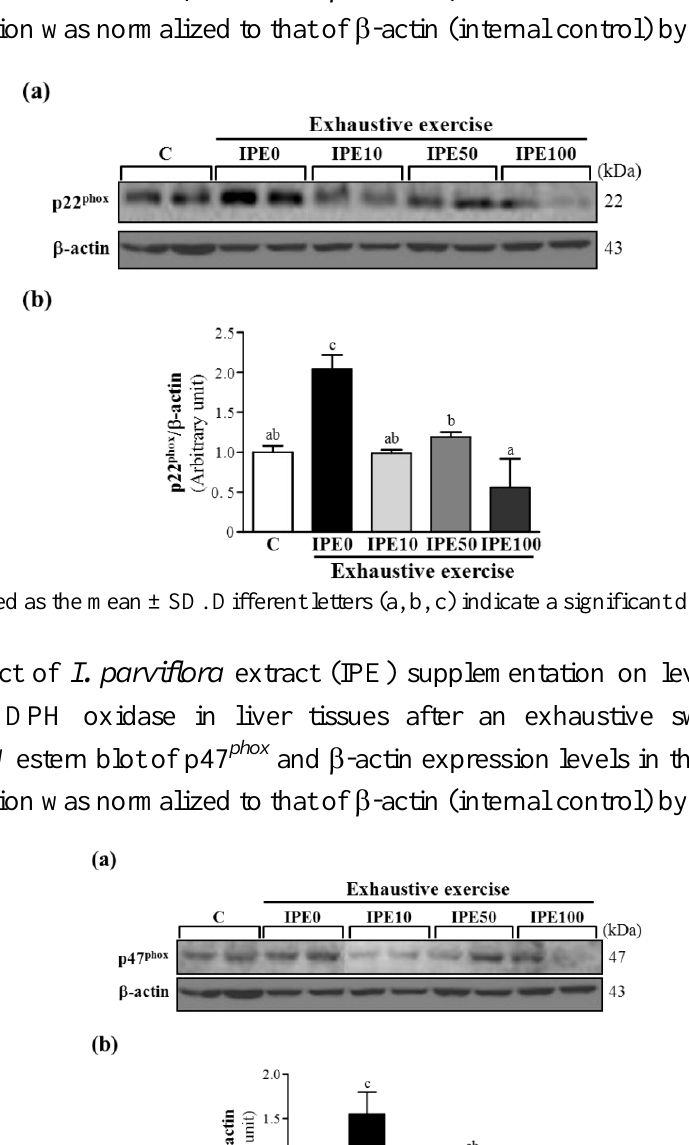
Figure 4. Effect of I. parviflora extract (IPE) supplementation on levels of the p22 phox subunit of NADPH oxidase in liver tissues after an exhaustive swimming exercise challenge. ( a ) Western blot of p22 phox and  -actin expression levels in the liver; ( b ) p22 phox protein expression was normalized to that of  -actin (internal control) by densitometry.